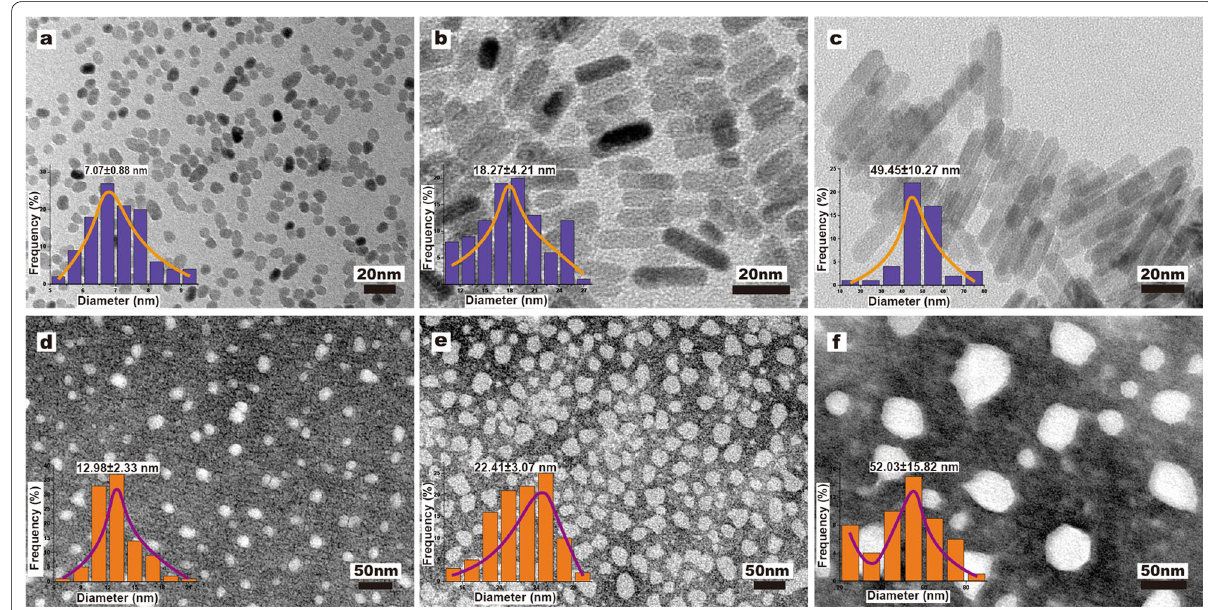
Fig. 1 The characterization of samples. a – c The TEM images and size distribution of pristine ZnO NPs (~ 7 nm; ~ 18 nm; ~ 49 nm). d – f Lipid-coated ZnO NPs (~ 13 nm; ~ 22 nm; ~ 52 nm), these samples were subjected to the negative staining techniques. In panels ( a – f ) the inserted figures show the size distribution of samples from the TEM images, n 100 or =